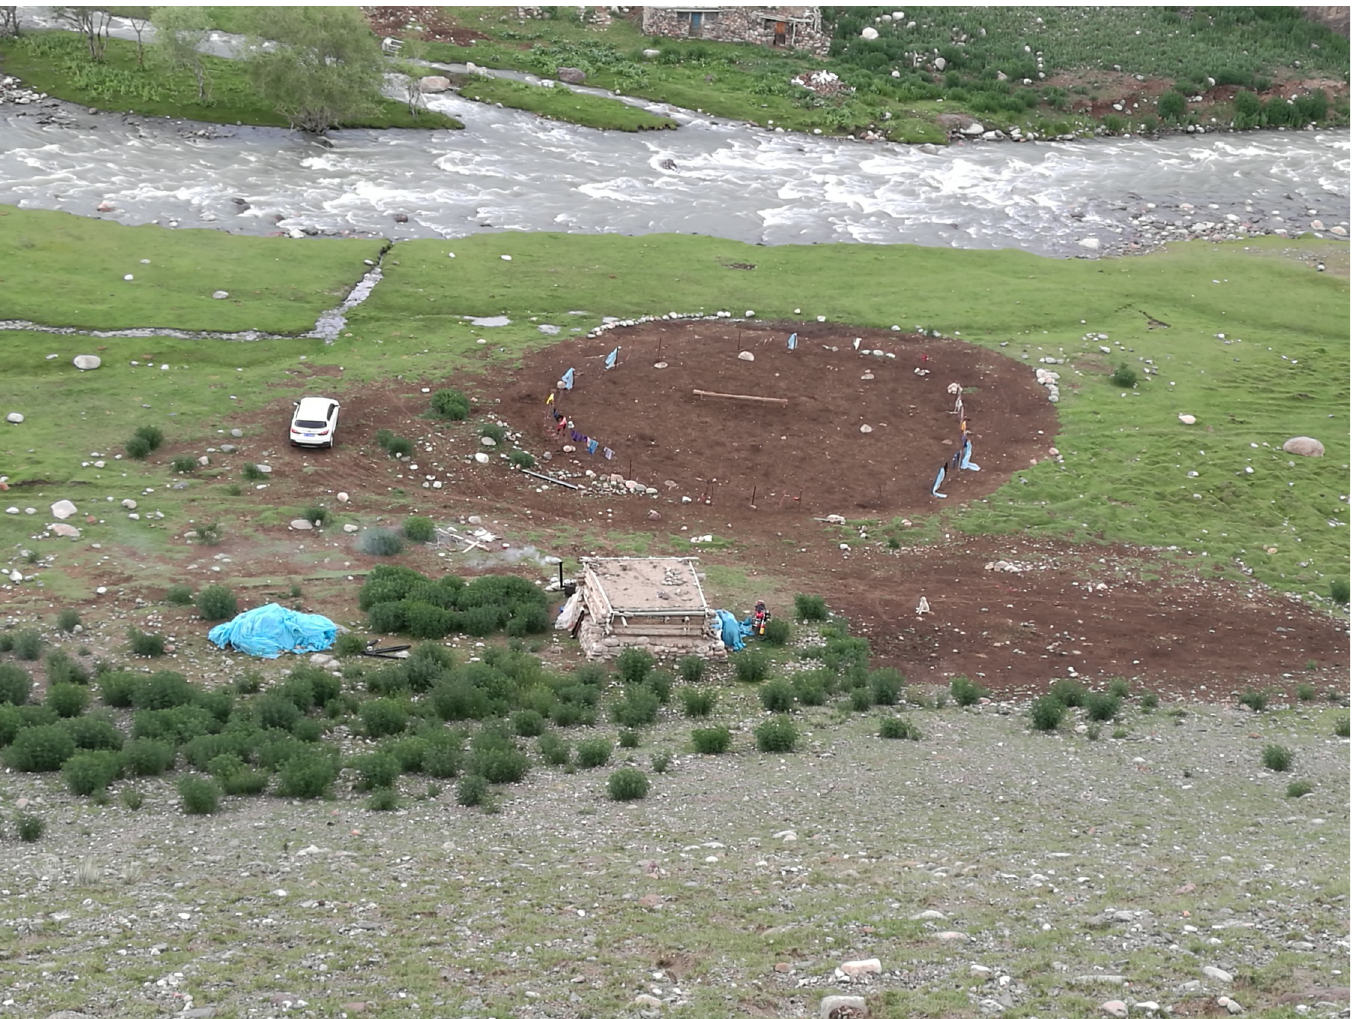
Fig 9. Intermediate campsite used during the spring–summer transhumance (1800 m. a.s.l.). The circular dark patch of soil surrounded by a fence is the animal fold. The small log-built hut sees only seasonal use for the herders to stay (P.